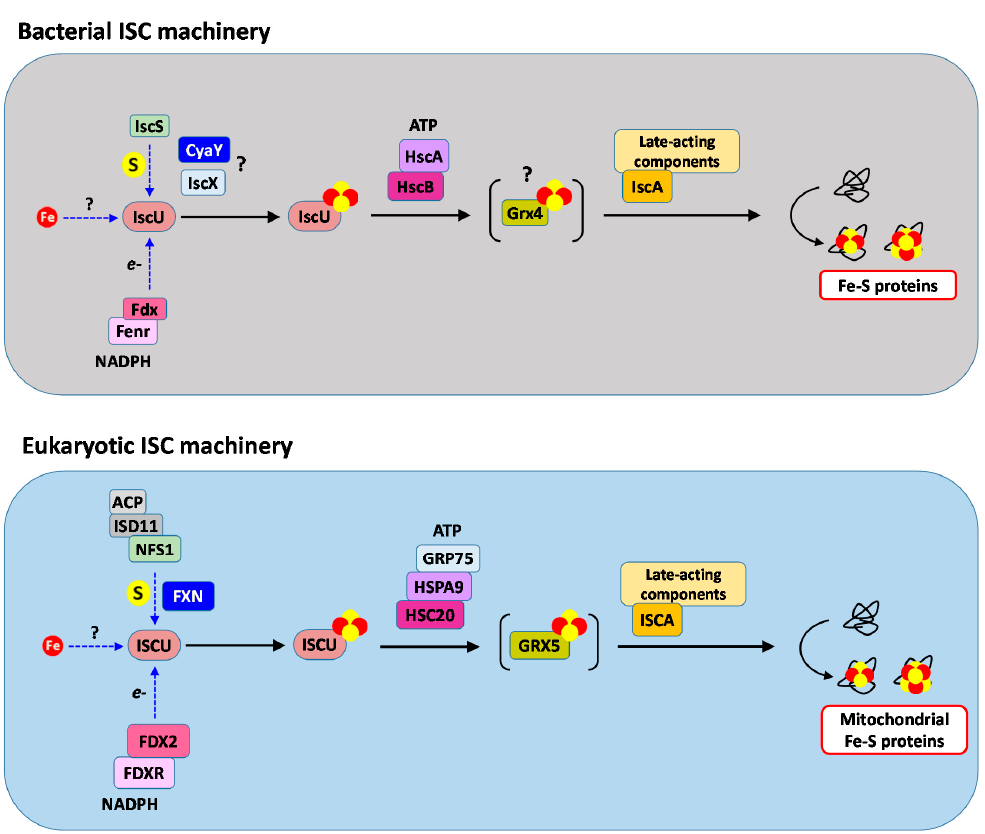
Figure 1. Main components of the bacterial and eukaryotic ISC machineries. The bacterial ISC machinery encompasses proteins encoded by the ISC operon (IscU, IscS, IscX, Fdx, HscA, HscB and IscA), as